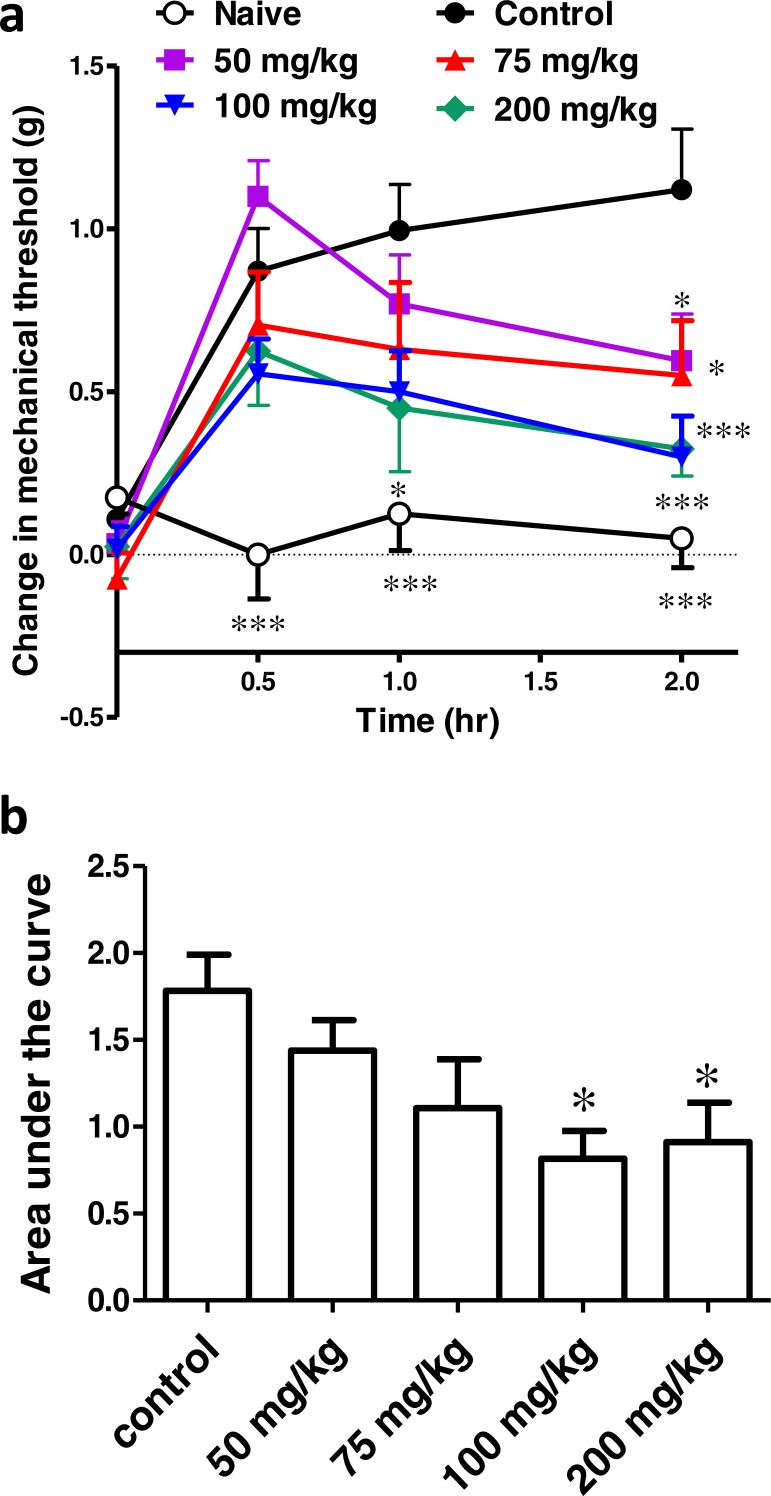
Effect of different doses of ibuprofen, administered i.p., on surgical incision-induced tactile allodynia in mice.(A) Line graph representing the difference in 60% mechanical threshold between the incised and non-incised paws in different groups at different time points (the change in mechanical threshold). Ibuprofen was administered 30 min before the incision at doses of 50, 75, 100 & 200 mg/kg i.p. Data are presented as mean ± S.E.M., where ∗ indicates p < 0.05 and ∗∗∗ indicates p < 0.001, compared to the control group (two-way ANOVA followed by Bonferroni’s post-test; n = 8). (B) Area under the curve of the upper figure (the area under the change in mechanical threshold-time curve; AUC0–2h), ∗ indicates p < 0.05 compared to the control group (One-way ANOVA followed by Dunnett’s multiple comparison test).